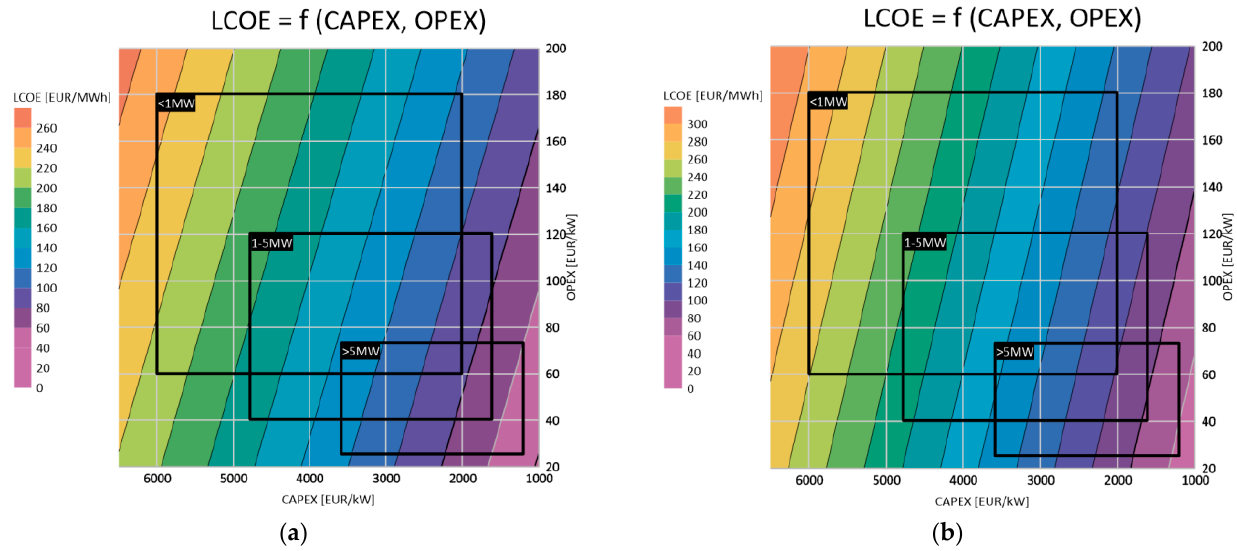
Figure 3. The total cost LCOE WACC rate of 11.4% and life time: ( a ) 50 years; ( b ) 15 years. Source: own elaboration. For the lifetime of hydropower plants (50 years) for micro and small power plants, LCOE EUR 100–200/MWh is about twice as much as for WACC = 7%, where LCOE was in the range of EUR 60–120/MWh. Similarly, about 1.5 times higher values occur for the 15 ‐ year analysis period.